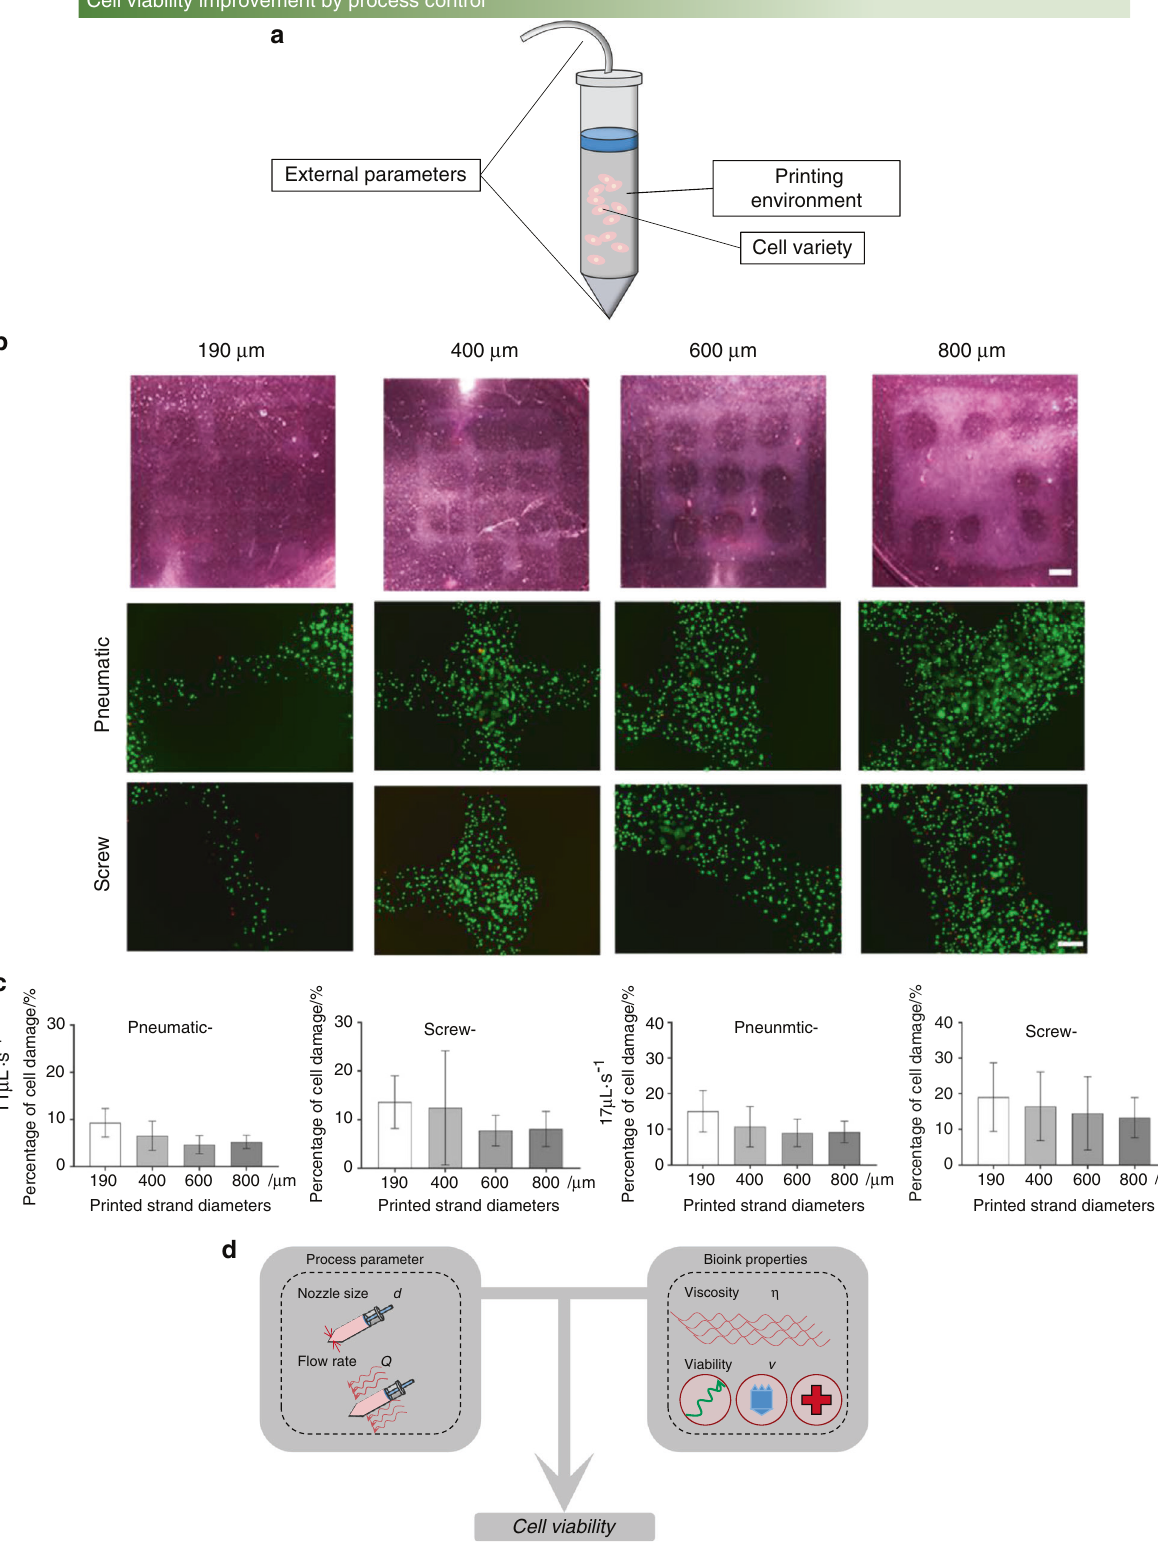
Fig. 5 The factor in fl uencing cell viability. a The three reasons affecting cell viability and differentiation. b Live/dead assay of cells with two pressure methods (pneumatic and screw) at different printing speeds. 92 c Cell damage tests of four different diameters. 92 d Two factors, process parameters and bioink properties, affect cell viability; process parameters, including nozzle size and fl ow rate; and bioink properties, including viscosity and viability. (Figures adapted with permission from Ning et al. 92